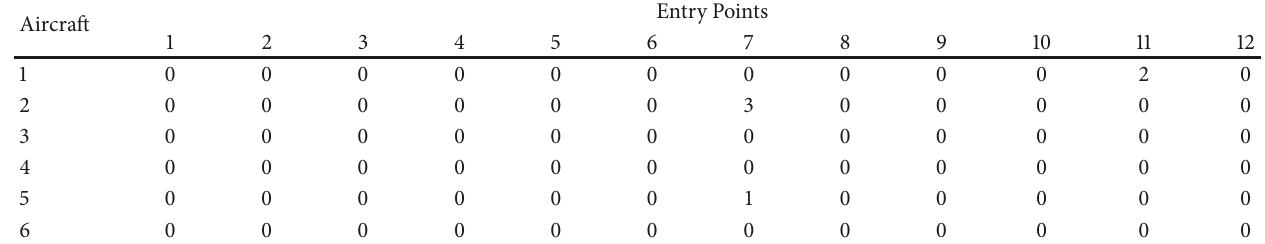
Table 5: Tabu list